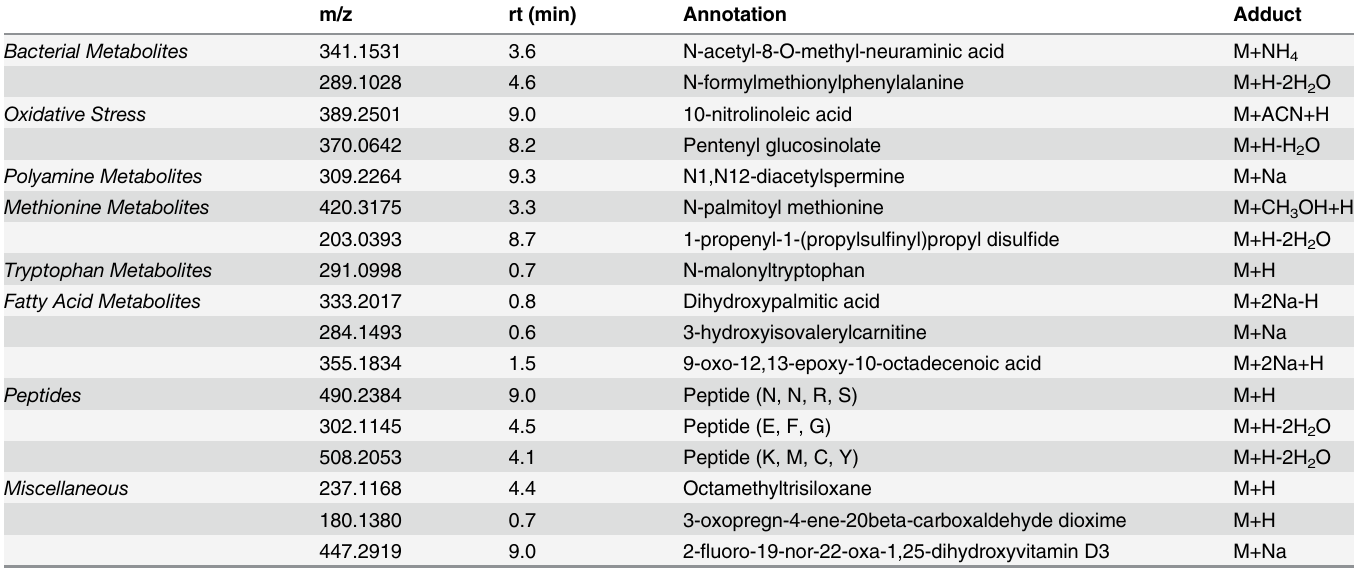
Table 2. Selected m/z features increased in AUD subjects.